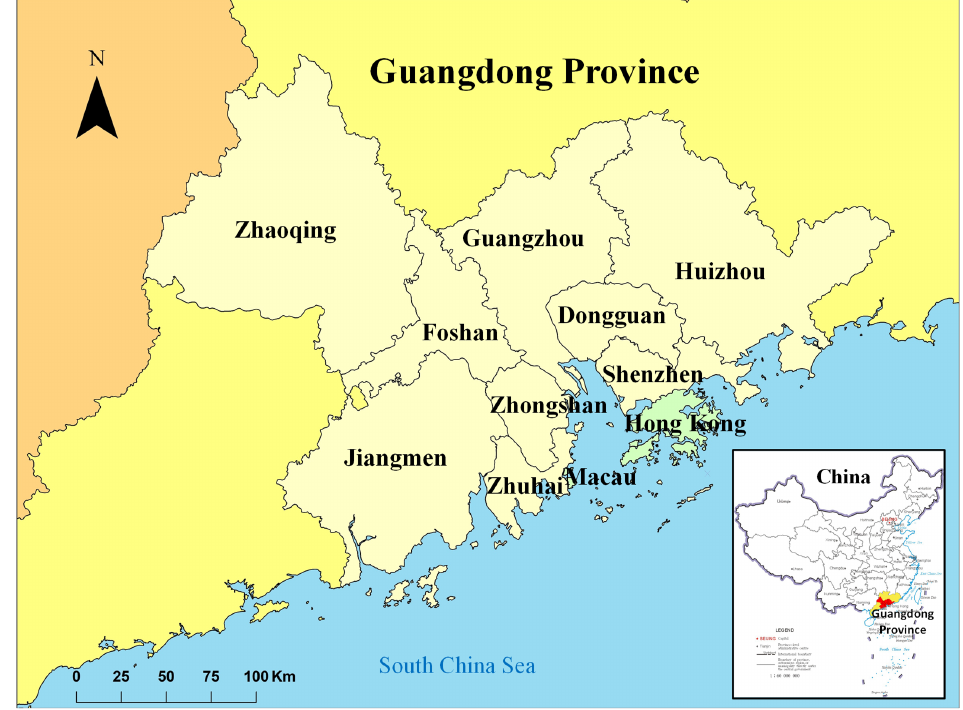
Figure 1. Location of the Pearl River Delta in China.